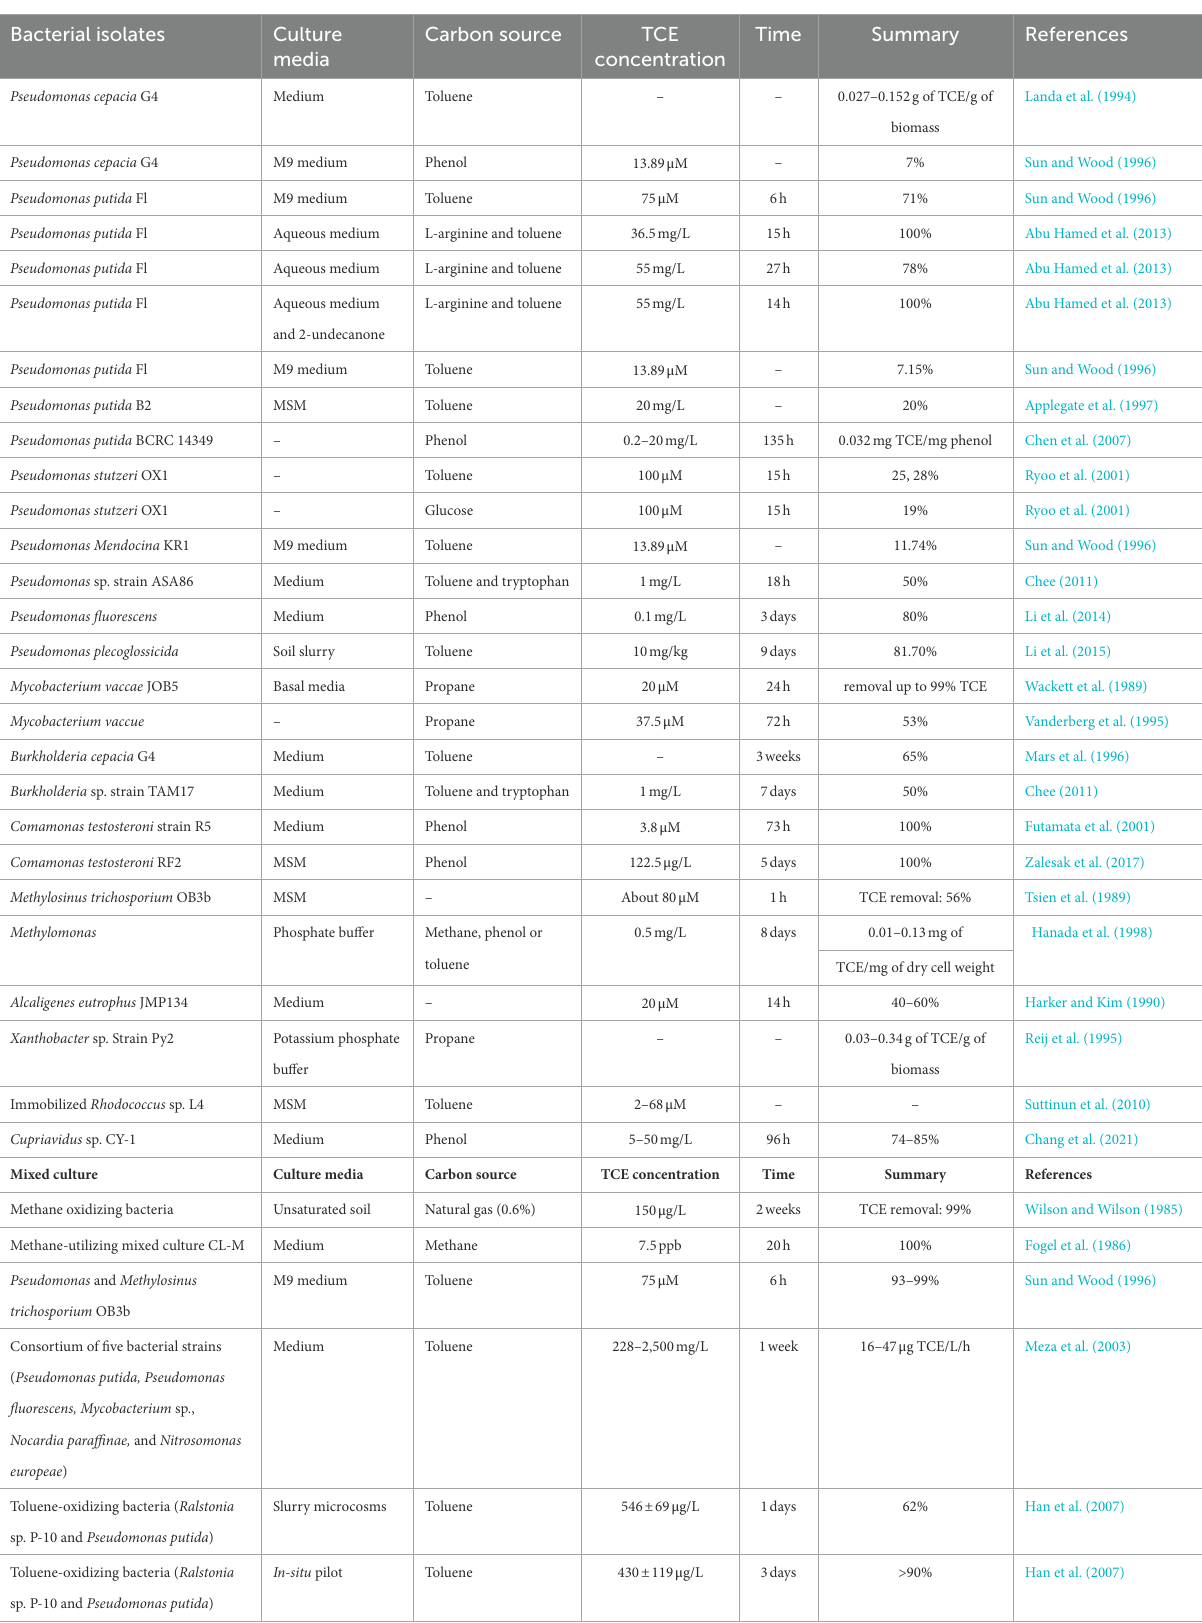
TABLE 4 Aerobic co-metabolism of TCE by bacterial isolates and mixed culture. Bacterial